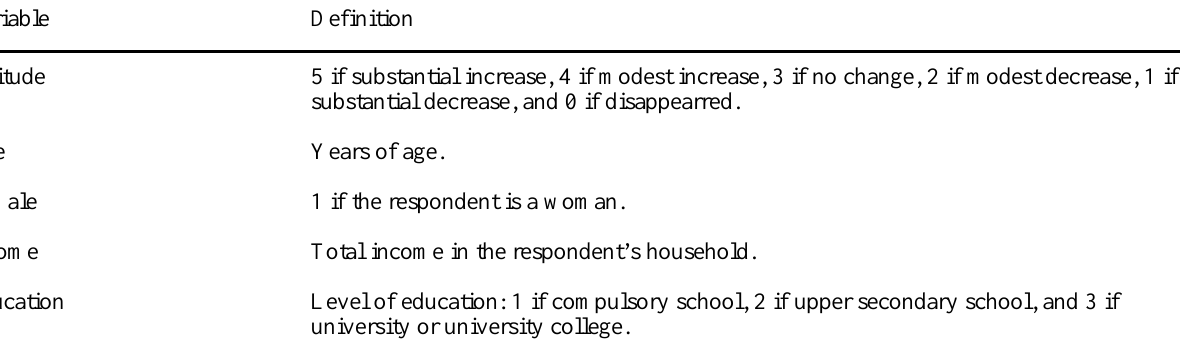
Table 1. Definitions of variables used in the analysis.